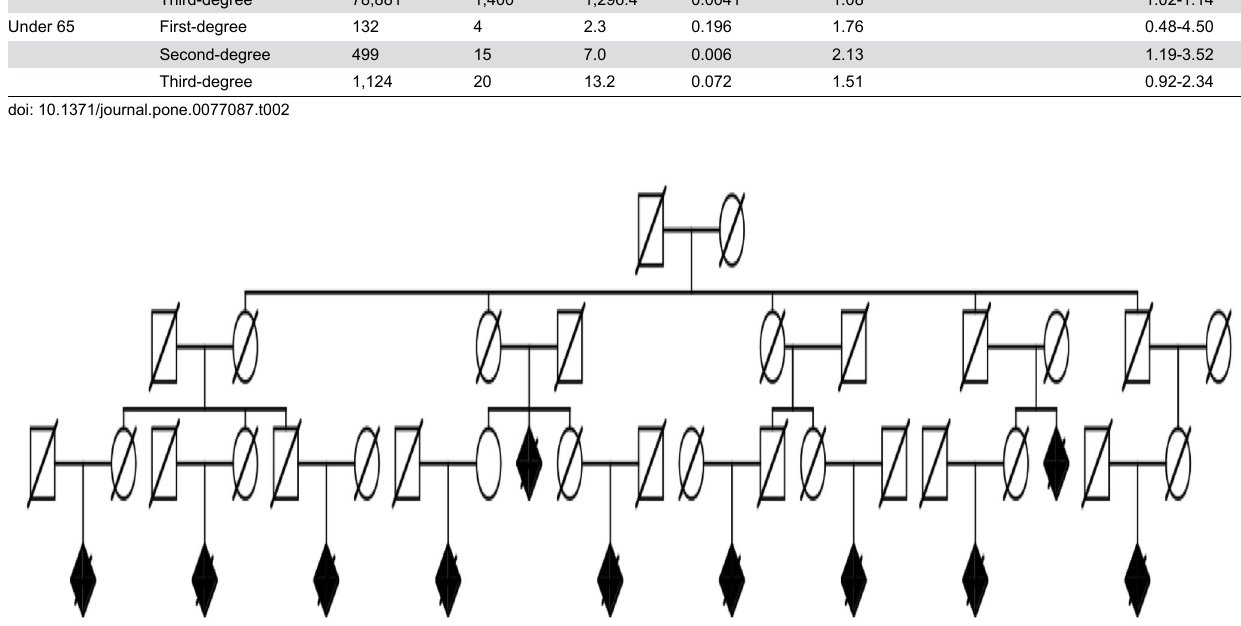
Age at Death # relatives observed